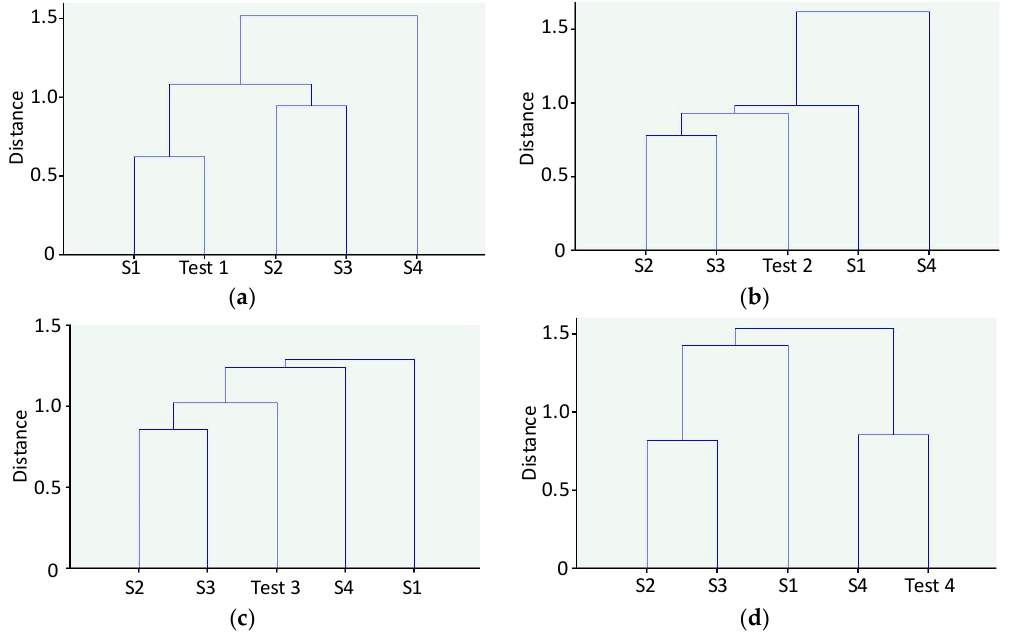
Figure 6. Results of the clustering analyses performed for cases: ( a ) Test 1; ( b ) Test 2; ( c) Test 3; ( d ) Test 4. S1, S2, S3, and S4 denote the Sample 1, Sample 2, Sample 3, and Sample 4, respectively.